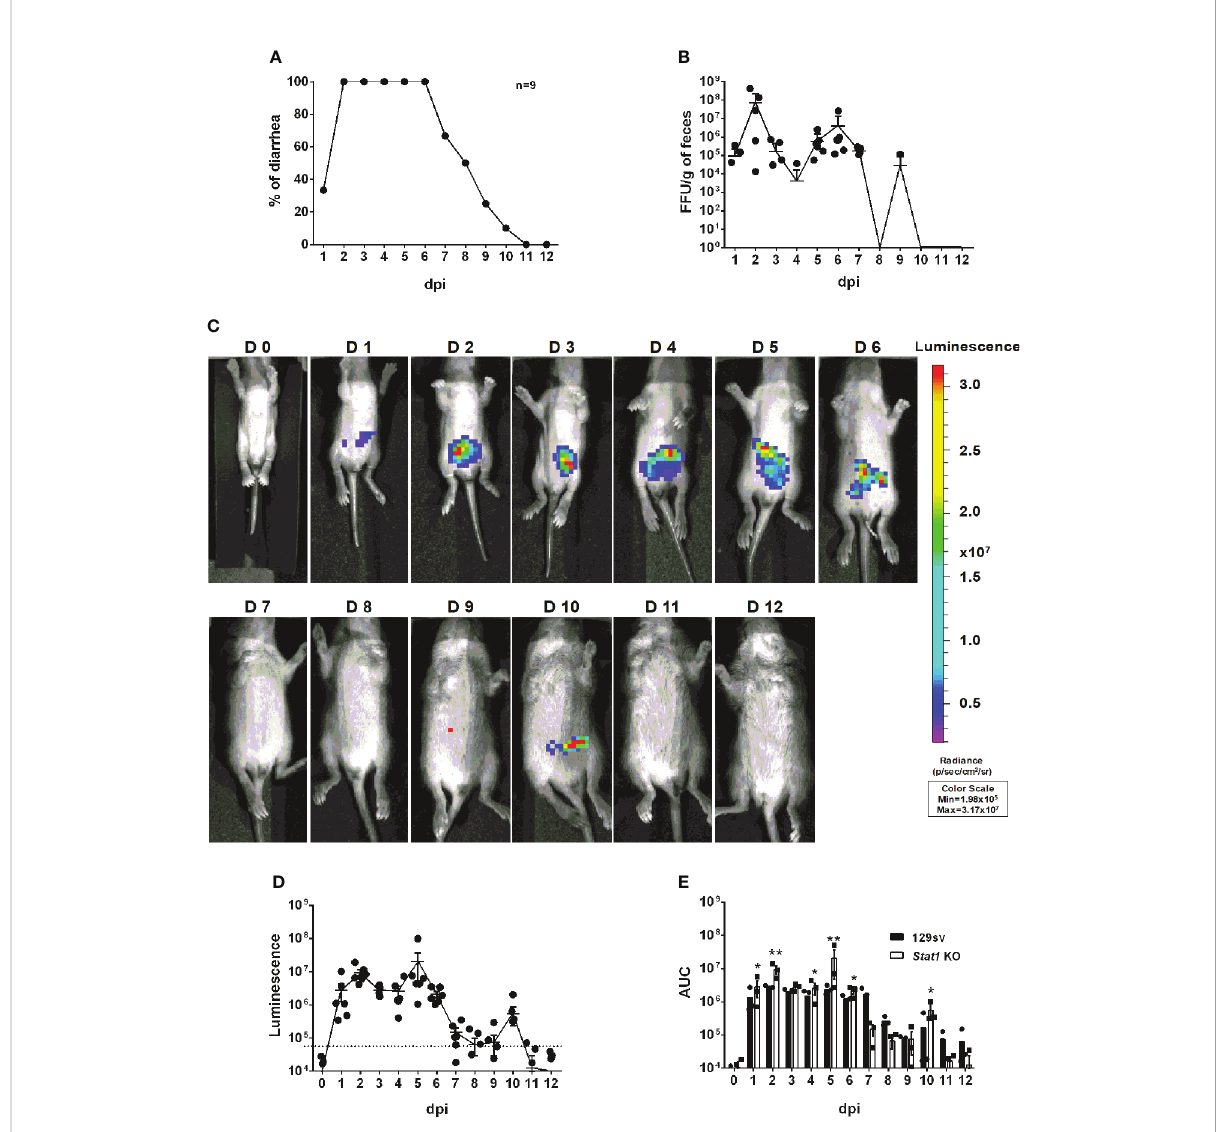
FIGURE 6 Characterization of rD6/2-2g-NLuc infection in Stat1 KO 129sv mice. (A) Five-day-old Stat1 KO 129sv mice (n=9) were orally inoculated with 3.5×10 3 FFUs of rD6/2-2g-NLuc. The diarrhea rate was monitored from 1 to 12 days post infection. (B) Viral shedding in stool samples was detected by an FFU assay and normalized by to feces weight. (C) Representative images of rD6/2-2g-NLuc infected Stat1 KO pups (1 to 12 days). The bioluminescent signal is expressed in photons per second per square centimeter per steradian (p/sec/cm 2 /sr). (D) Quanti fi cation of the luminescence in (C) . The dashed line indicates the upper limit of detection. (E) Statistical analysis of area under the curve (AUC) comparing data in Figure 4D and (D) . Error bars show the SEM (one-way ANOVA test; * P < 0.05, ** P <